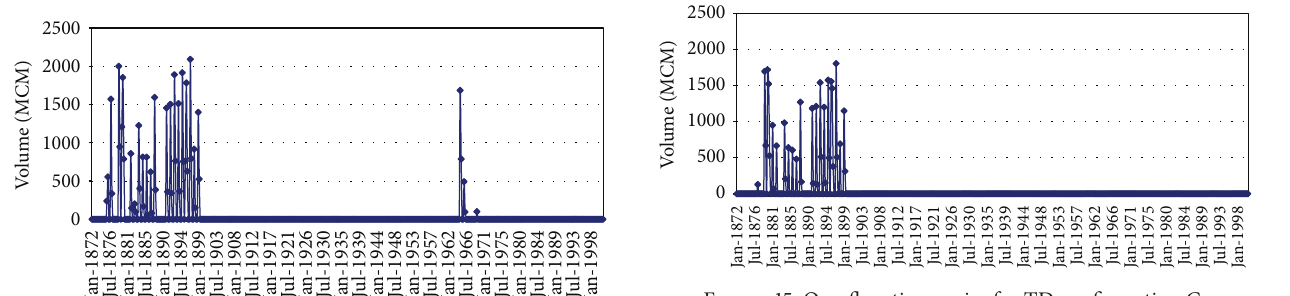
Figure 15: Overflow time series for TD configuration C.